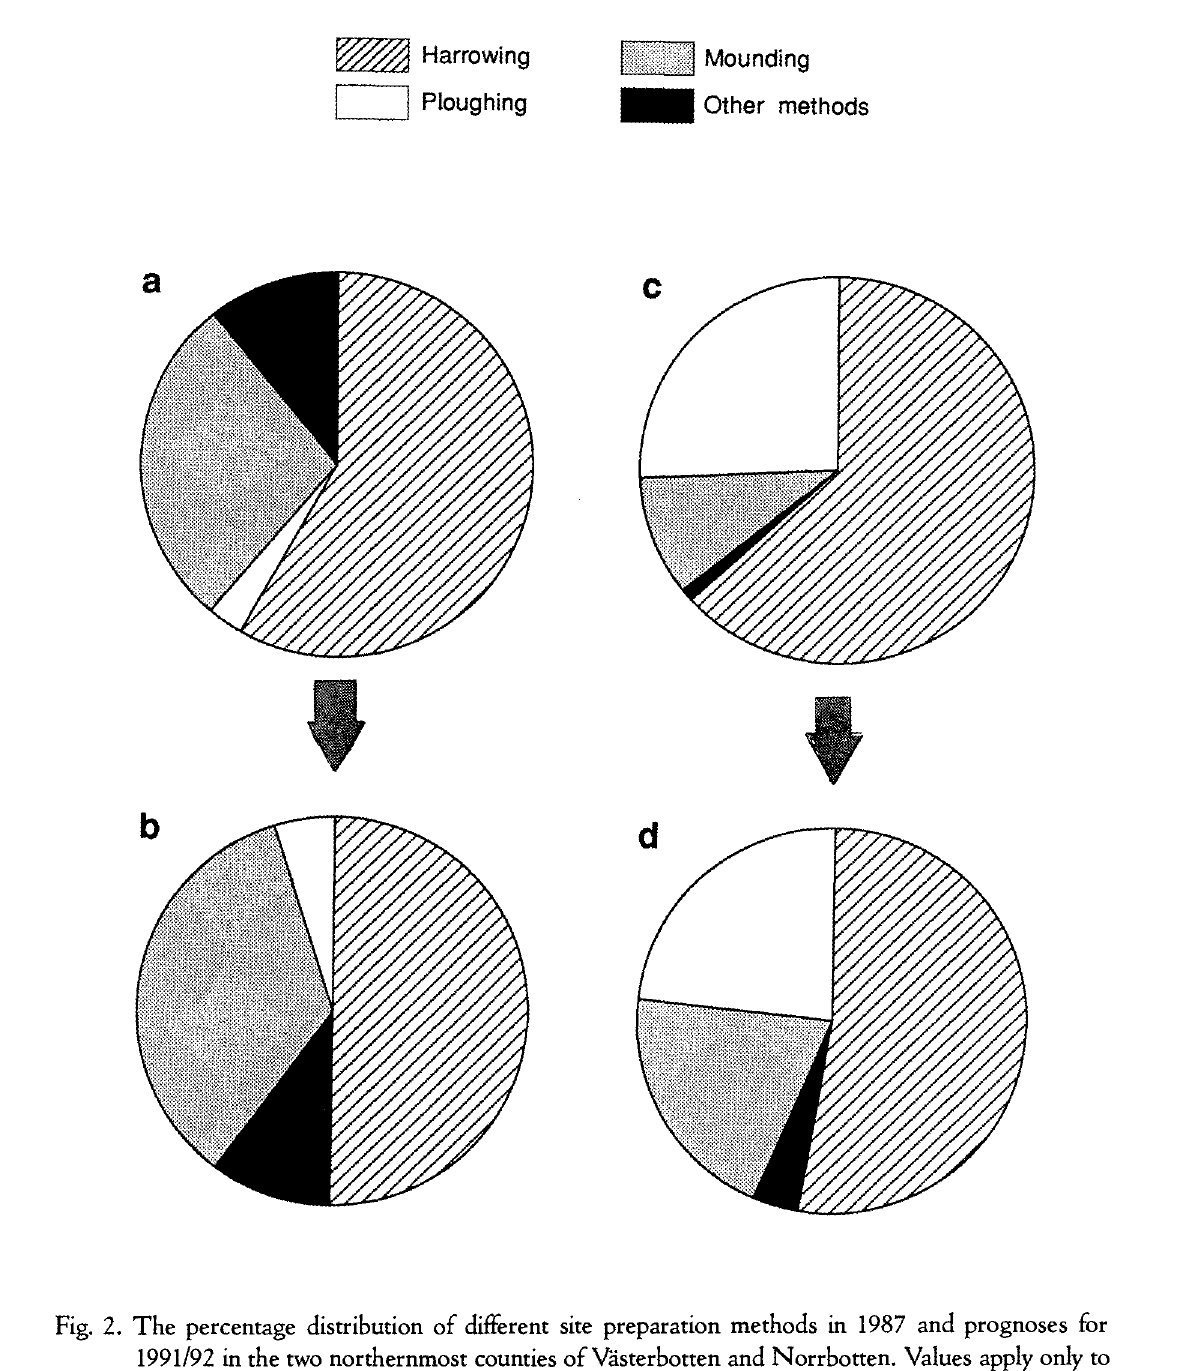
Fig. 2. The percentage distribution of different site preparation methods in 1987 and prognoses for 1991/92 in the two northernmost counties of Vasterbotten and Norrbotten. Values apply only to state-owned forests. (Source: The National Forest Enterprise of